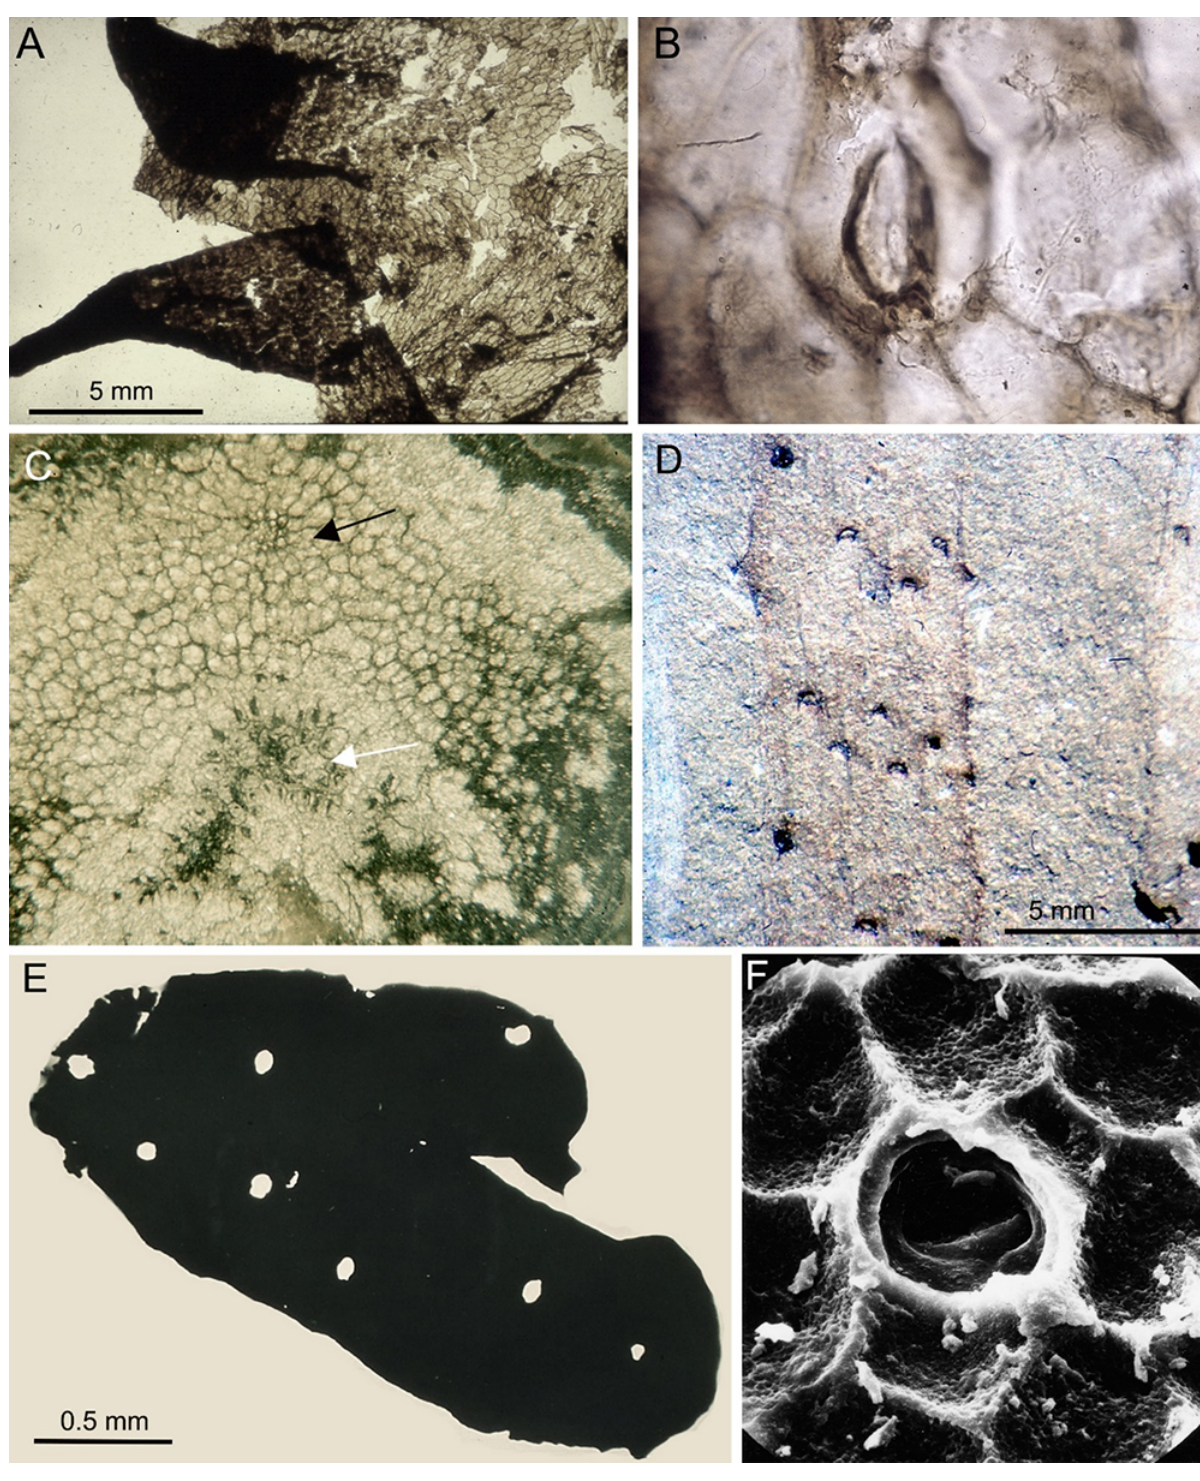
Figure 4 Early Devonian (Emsian) plants from Poland. Lycophyte Drepanophycus spinaeformis , Andrychów 2 and Andrychów 4 boreholes: ( A ) fragment of shoot cuticle with two leaves; ( B ) stoma; specimens unnumbered. Trimerophyte Psilophyton szaferi , Modrzewie 2A borehole: ( C ) Transverse section of axis showing a dividing vascular strand below branching (black arrow) and secretory cells (white arrow), S/99/8; ( D ) Fragment of axis impression showing irregularly distributed enations in the form of rounded swellings. Nematophyte Spongiophyton . (E) Spongiophyton sp. 1 – fragment of dichotomously branching thallus, outer side of upper surface, slide 10/1, Andrychów 2 borehole; ( F ) Spongiophyton sp. 2 – fragment of thallus showing outer side with pores, Suskowola borehole. All specimens stored in PC IB UJ (photos by D. Zdebska).